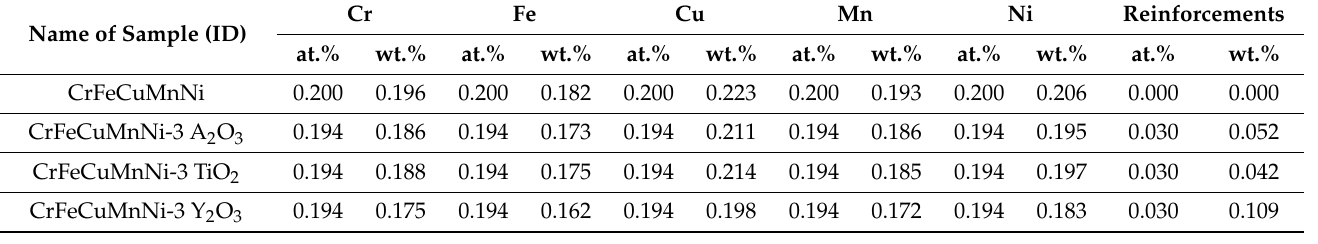
Table 1. Chemical composition of synthesized oxide-dispersive strengthened high-entropy compos- ites (ODS-HECs) of CrFeCuMnNi, CrFeCuMnNi-3 vol.% Al 2 O 3 , CrFeCuMnNi-3 vol.% TiO 2 , and CrFeCuMnNi-3 vol.% Y 2 O 3 .